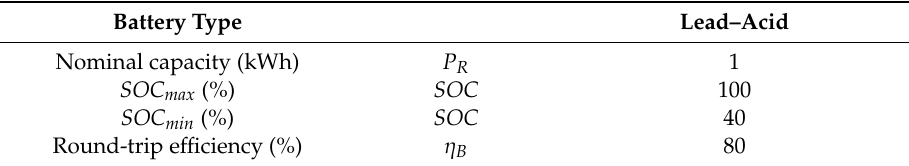
Table 3. Main input data used in the battery storage simulation [24].